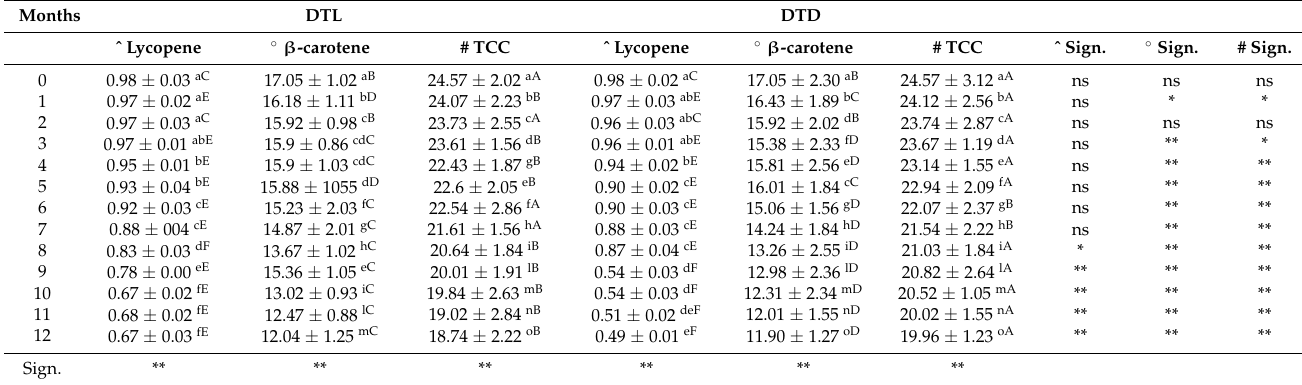
Table 4. β -carotene, lycopene, and TCC in “San Marzano” DTL and DTD samples (mg/100